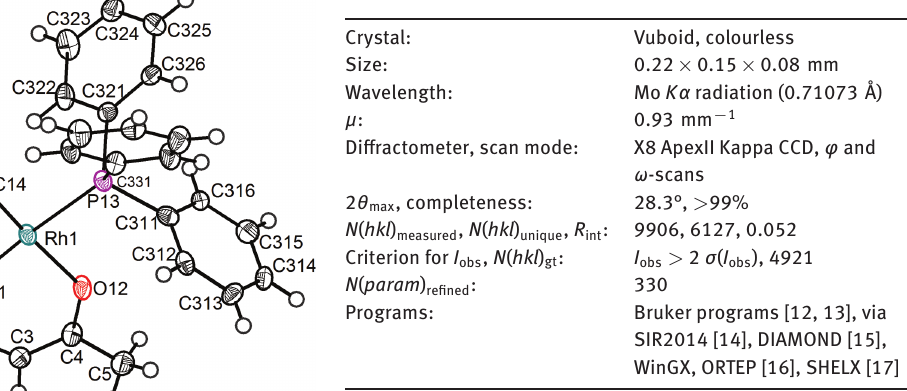
Table 1: Data collection and